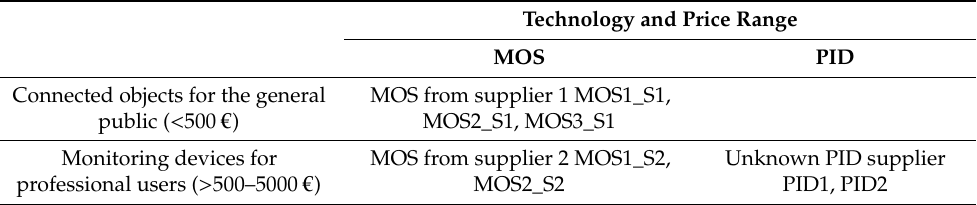
Table 4. Summary of technology / price range of tested TVOC monitoring devices.